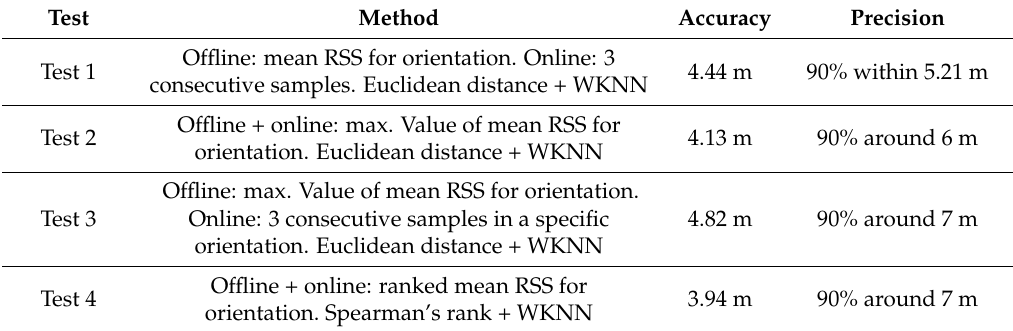
Table 11. Summary of WLAN tests presented in this study.